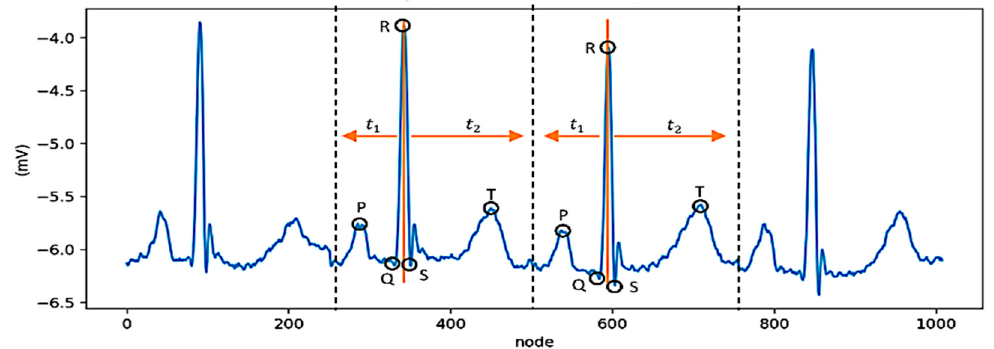
Figure 3. The ECG segmentation process.